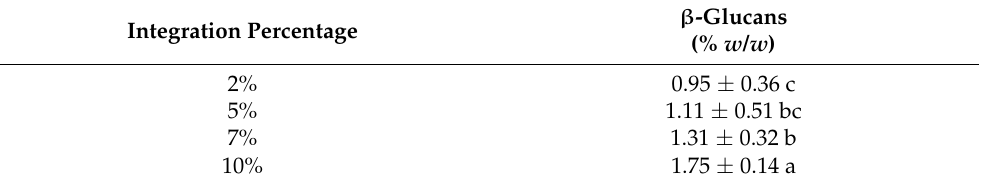
Table 12. β -Glucans contents (% w/w ) of the enriched breads, based on the raw materials (thin bran and barley flour) based on the level of inclusions, as determined by the two-factor ANOVA (analysis of